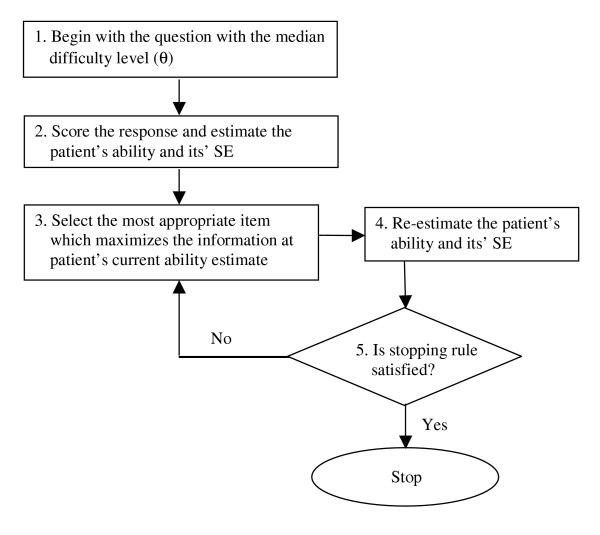
The flow chart of the CAT algorithm used in this study.